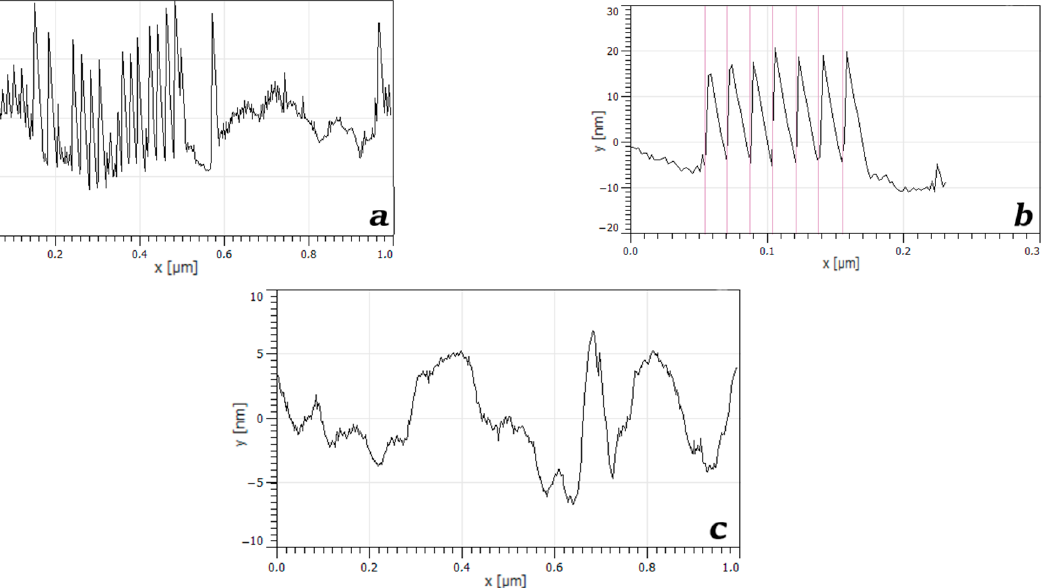
Figure 7. Comparison of the surface profiles of the initial ( a ) and irradiated xenon ions with an energy of 1 MeV/nucleon to a fluence of 10 8 cm − 2 thermoradiationally modified polytetrafluoroethylene ( c ). A fragment of the lamellar structure corresponding to a straight-line segment of white color on the topographic image of the surface of an unirradiated polymer ( b ).